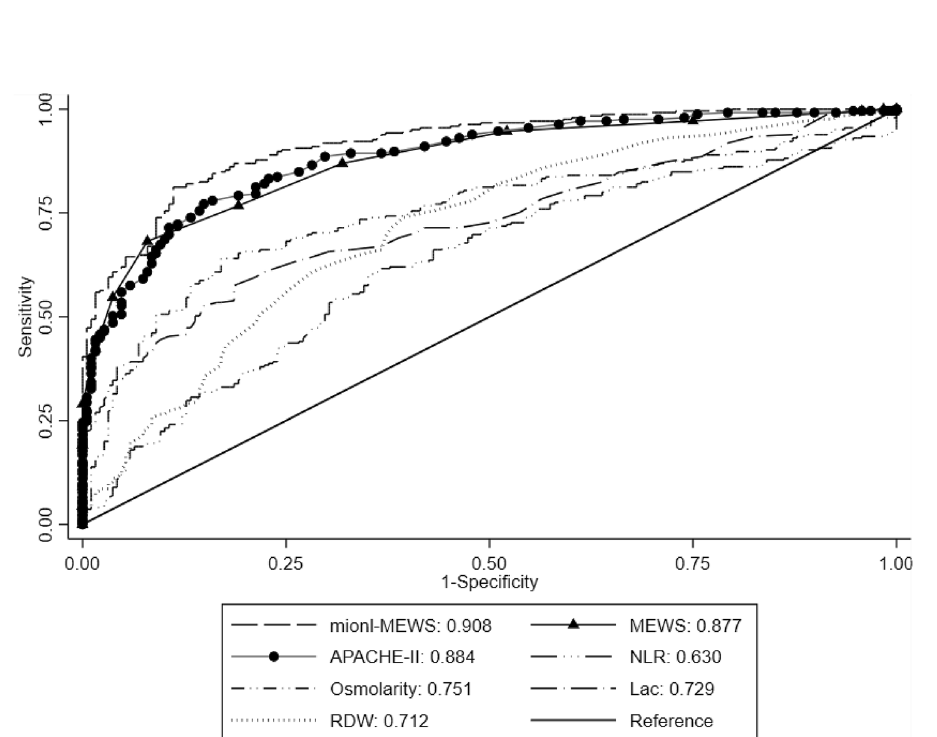
Figure 6. Predictive performance of the mionl-MEWS, APACHE-II, MEWS, neutrophil-to-lymphocyte ratio (NLR), red cell distribution width (RDW), lactate (lac) concentration, and osmolarity level for 28-day mortality in critically ill patients in the validation